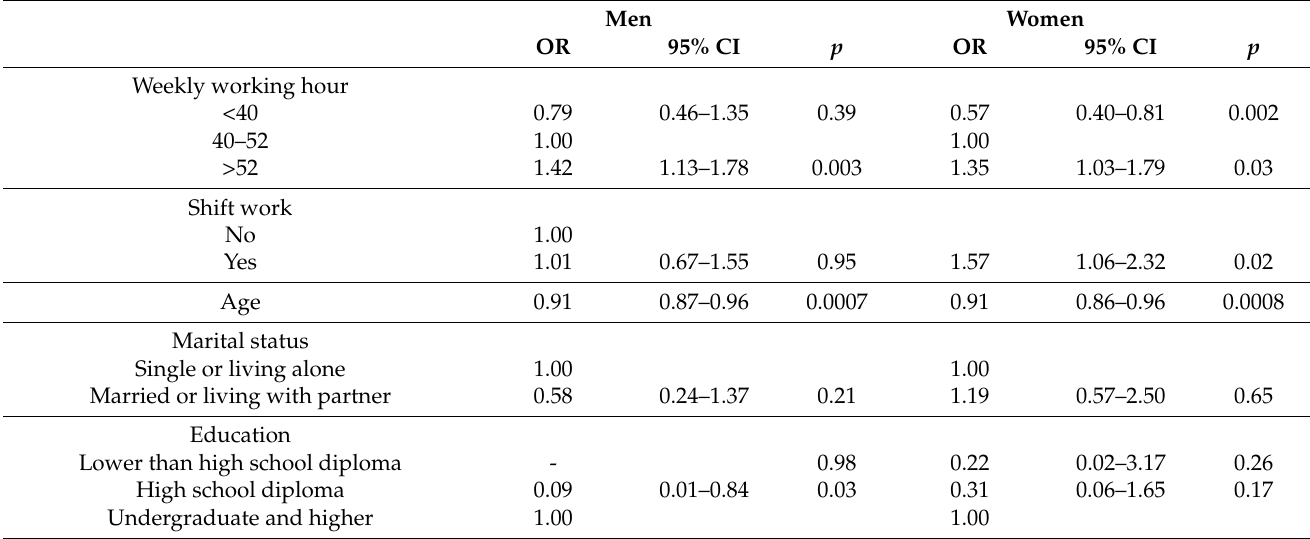
Table 3. Results from fixed effect logit models for the association between working hours and perceived unmet dental need due to time